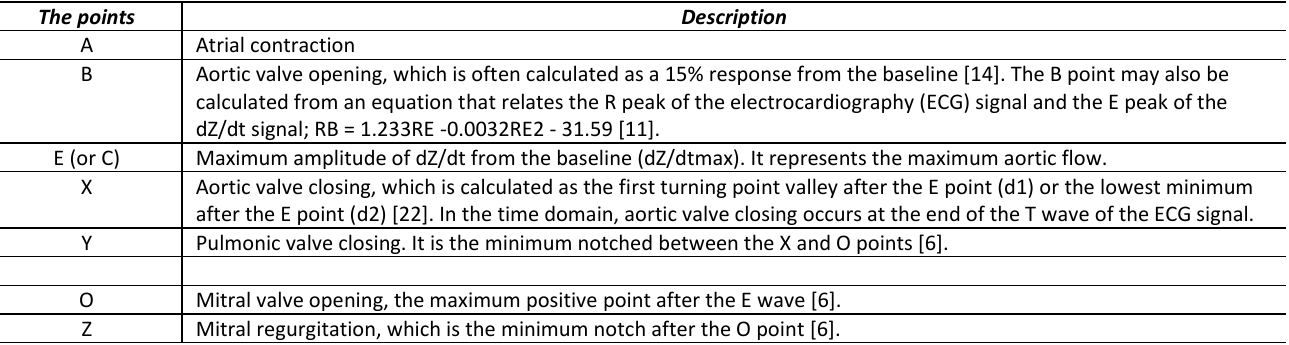
Table 1. Characteristic points of the dZ/dt signal.